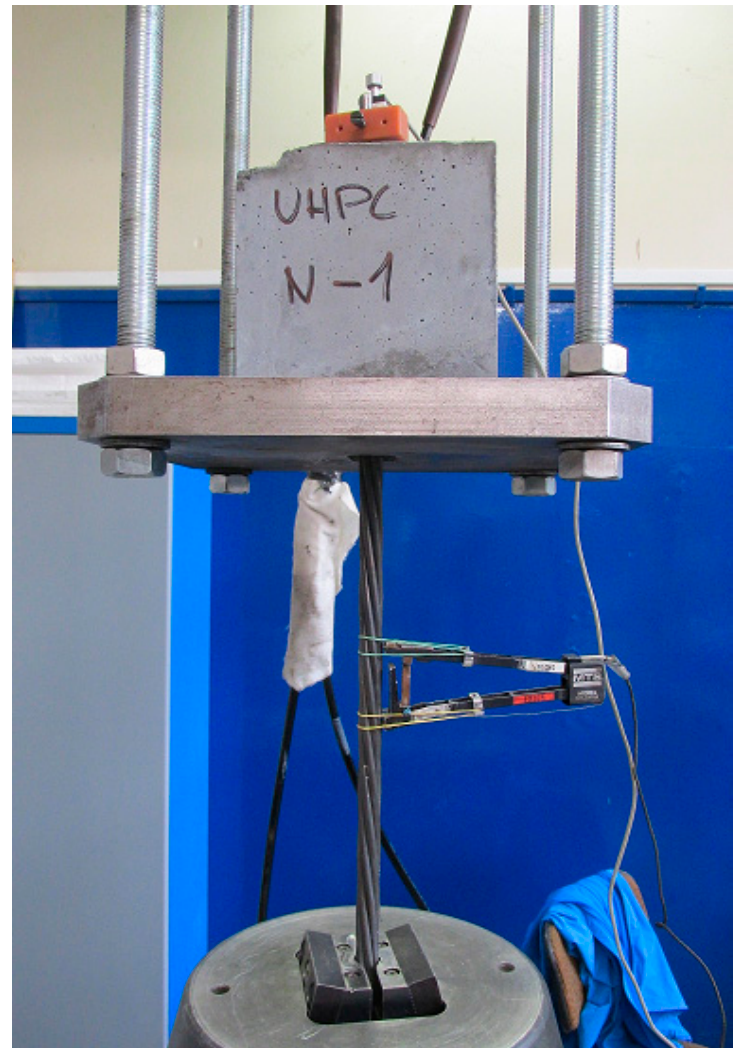
Figure 8. Experimental setup for bond strength (pull-out) test according to [26,27,29].